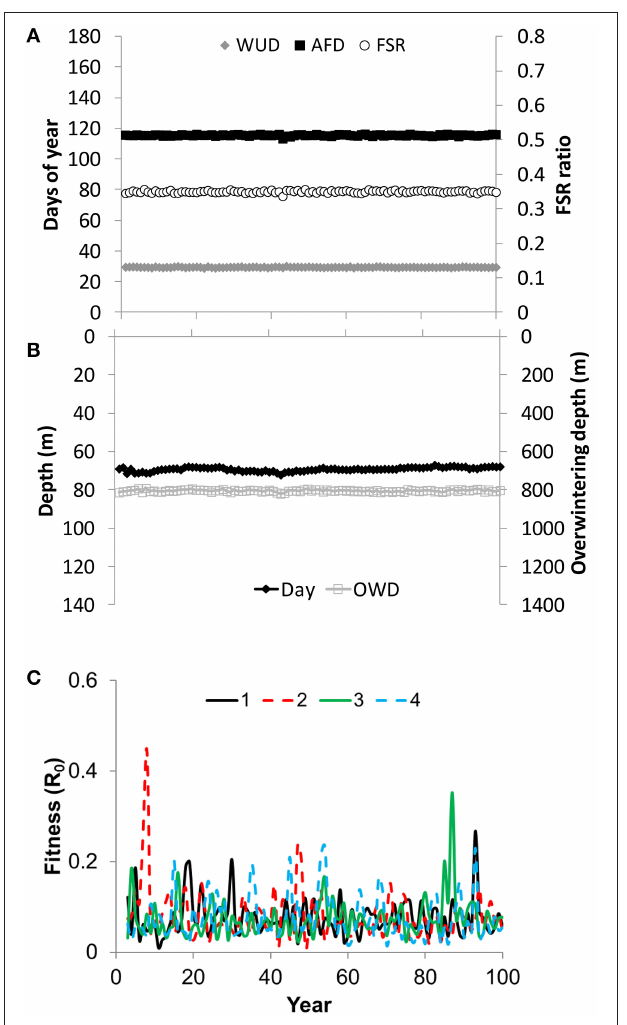
FIGURE 6 | The development over 100 years of the best replicate in simulation 4 in (A) wake up day (WUD), allocation to fat day (AFD) and fat to soma ratio (FSR) traits, (B) the day depth (DD) and overwintering depth (OWD), and (C) fitness (the net reproductive rate, R0) of all four replicates. Values are from end of each